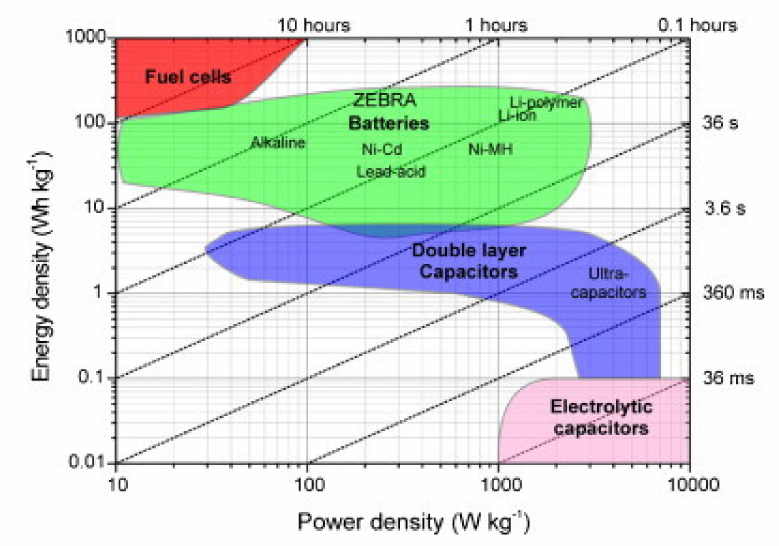
Figure 2. Ragone chart [24].